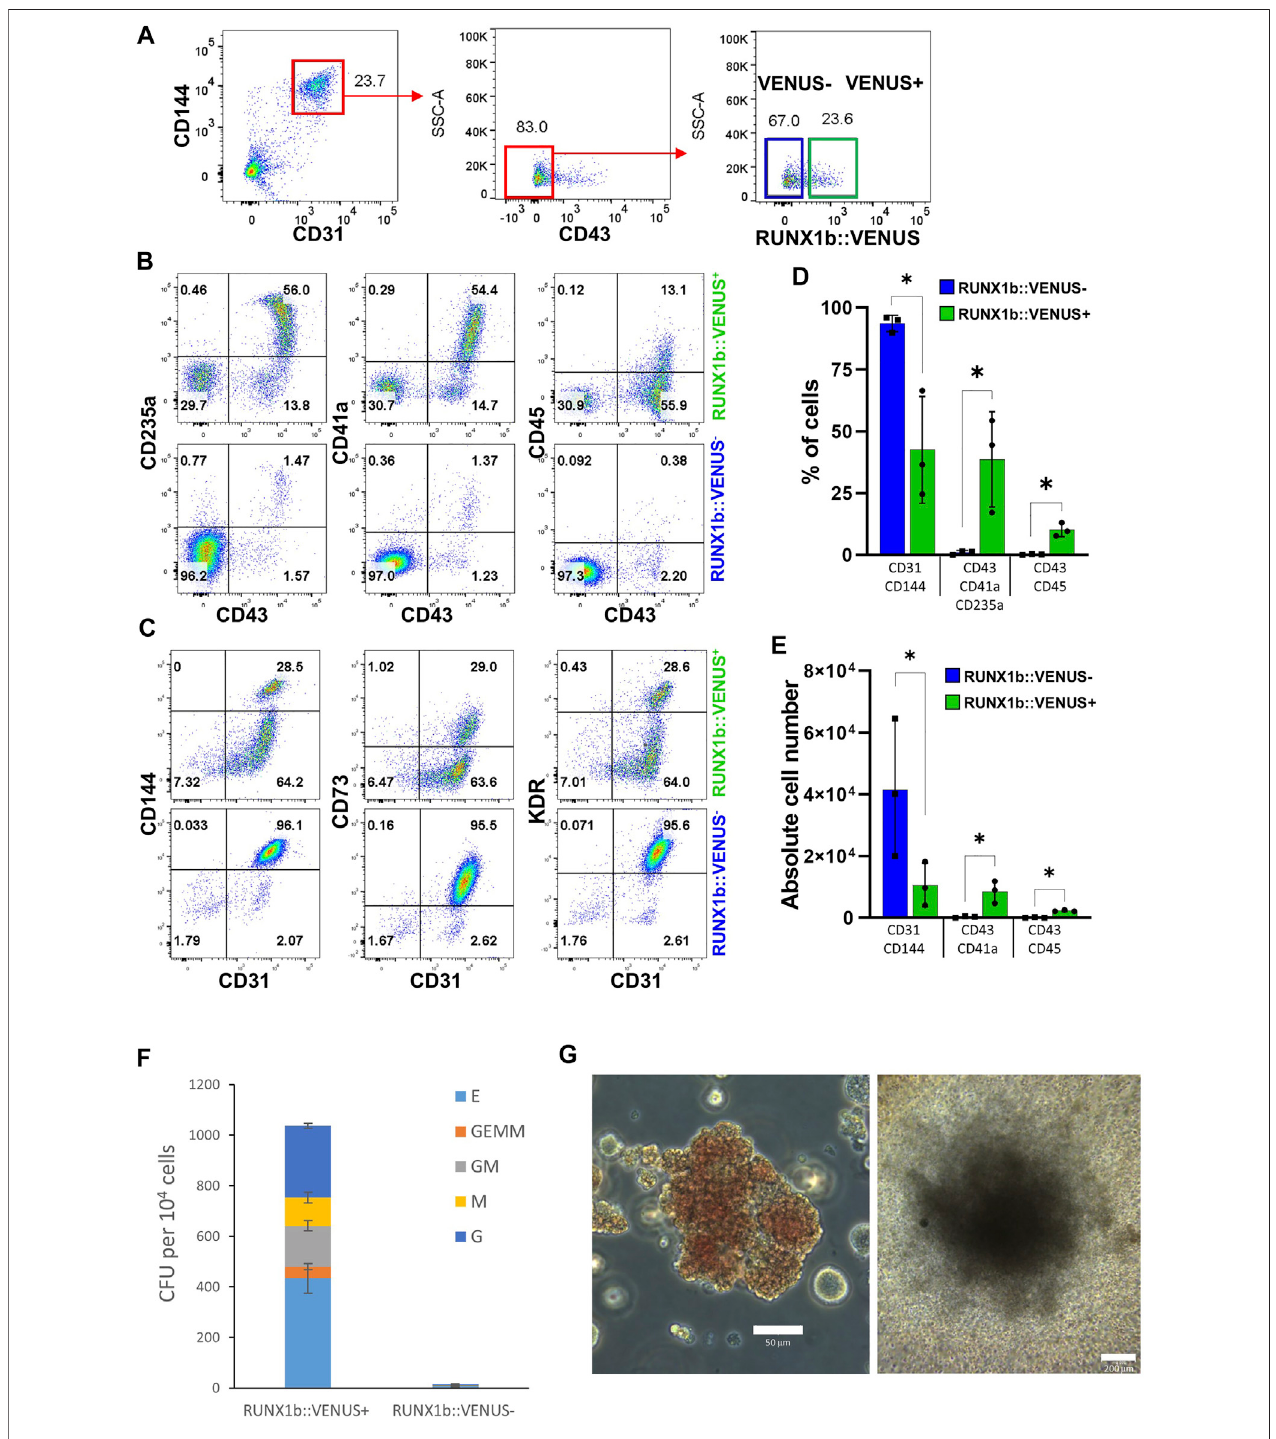
FIGURE3| TheRUNX1b:VENUSmarkshemogenicendothelium. (A) GatingstrategyusedtosortVENUSpositiveandnegativecellpopulationsfromday6 EBsfor hemogenicpotentialanalysis. (B,C) Flowcytometryanalysisfortheindicatedcellsurfacemarkersatday4ofhemogenicinducingculturesforthesortedVENUSpositive and negative cell populations. (D) Frequencies and (E) absolute numbers of endothelial (CD31 + CD144 + ) and hematopoietic (CD43 + CD41a + CD235a + and CD43 + CD45 + ) cells at day 4 of hemogenic inducing cultures from 3 independent experiments, data are presented as mean +/ − SD. Statistically signi fi cant differences were analyzed with unpaired t -test * p < 0.05. (F) Clonogenic potential of sorted VENUS positive and negative cell populations after 4 days of hemogenic inducing cultures. Data are presented as colony forming unit (CFU) for 10 4 cells as mean +/ − SD from 3 independent experiments, each experiment performed in biological triplicates. E: erythroid, GEMM: granulocyte-erythroid-macrophage-megakaryocyte, GM: granulocyte-macrophage, M: macrophage, G: granulocyte. (G) Representative photography of Erythroid (left) and GM (right) colonies, scale bar: 50 and 200 μ m, respectively. Cell colony morphology is representative of at least 3 independent experiments.